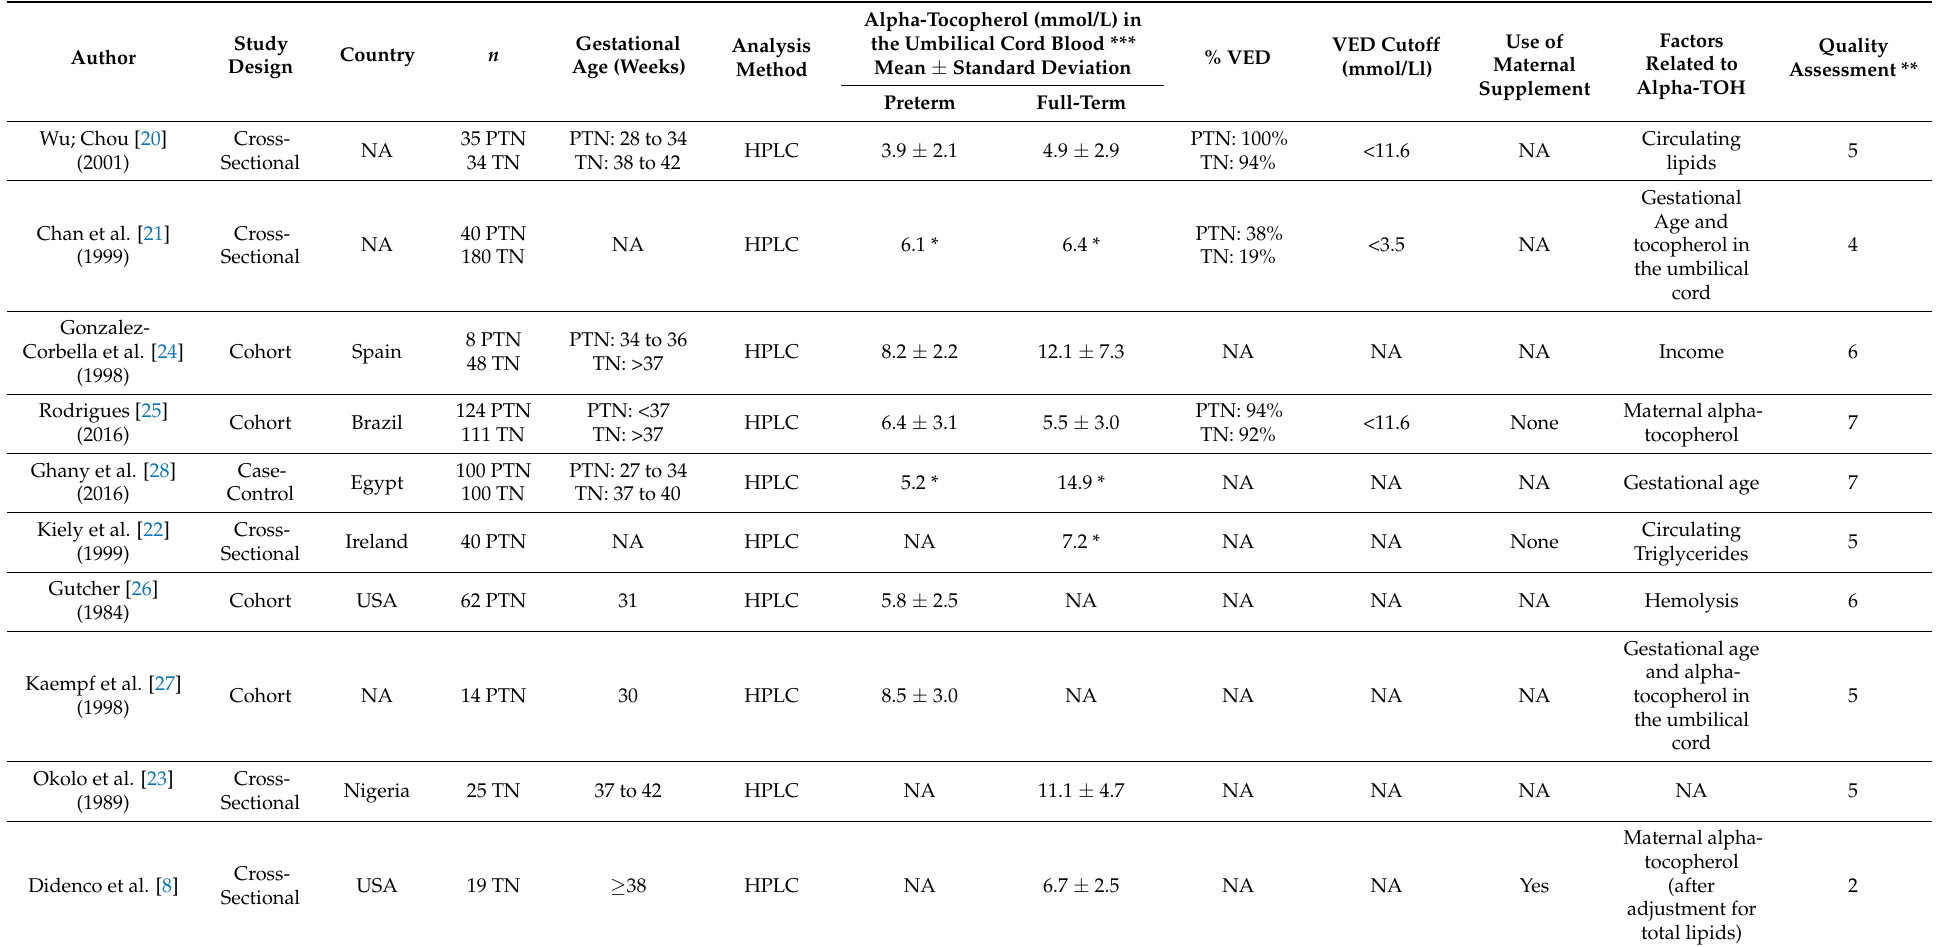
Table 2. Characteristics of the studies included in the systematic